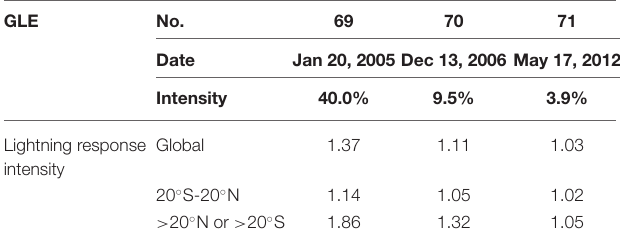
TABLE 2 | Lightning response intensities in different latitudinal zones for the three